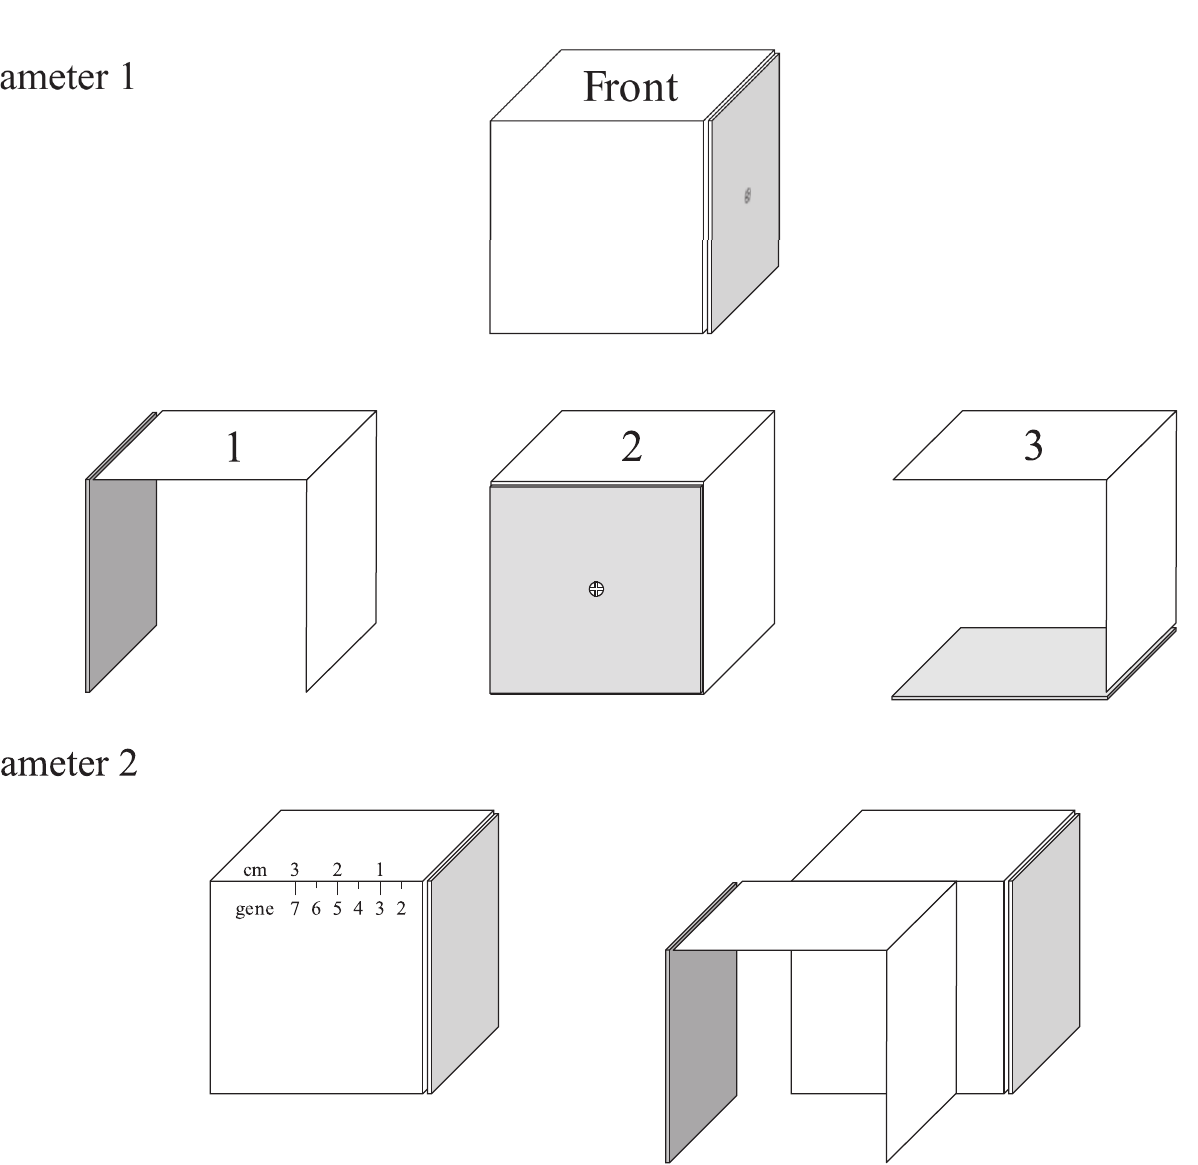
Fig 5. Morphological parameters. The morphological parameters of the child robot can be seen above. While the first parameter determinesthe orientationof the second cube in respect to the first, the second parameter determines the off-set betweenthese cubes. In the exampleabove, the first parameter is 1 whilethe second parameter is 3, with a 1 cm gap betweenthe